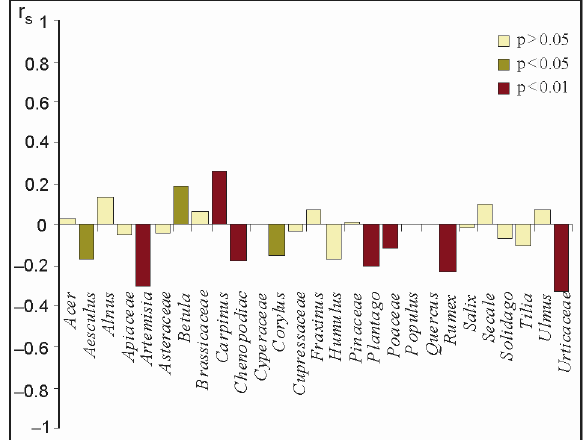
Fig. 5. Correlation coefficients (r s ) of plants pollen concentra- tion of various genera and families during the pollen season and wind velocity in 2004 –